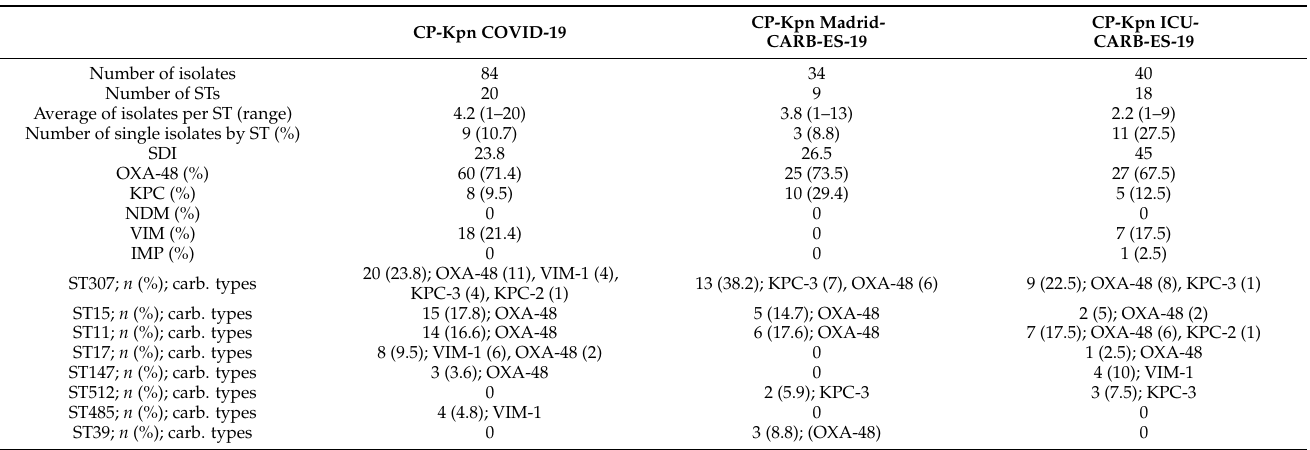
Table 3. Comparative data of the population structure of carbapenemase-producing K.